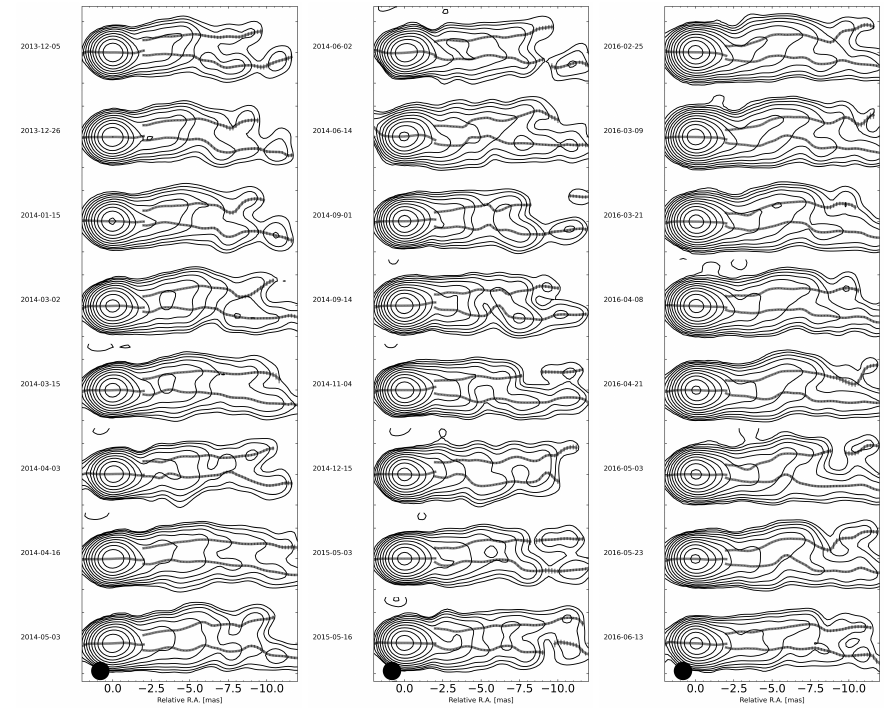
Figure 2. Ridge lines distribution of the M87 jet at 22GHz from KaVA observations in December 2013 to May 2014 ( left ), June 2014 to May 2015 ( middle ), and February 2016 to June 2016 ( right ). The contours represent the total intensity. Contours start at 3 σ rms , increasing in steps of 2. The σ rms of each epoch is listed in Table A1. The black circles in the bottom left corner represent the size of the restoring beam, namely 1.2mas circular Gaussian. All images have been rotated by −